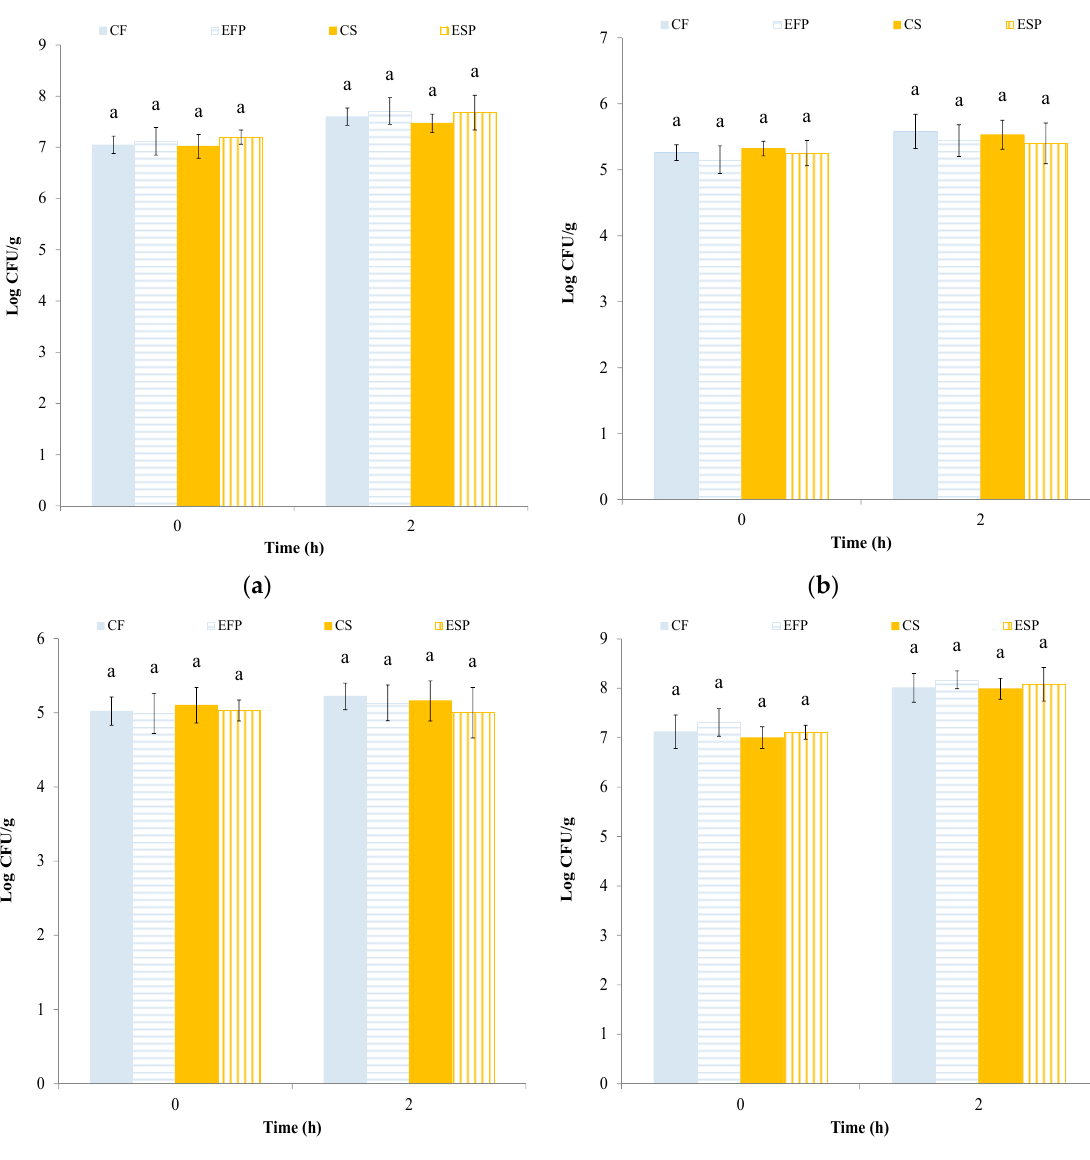
Figure 1. Microbiological counts during fermentation. ( a ) PCA, plate count agar for total mesophilic microorganisms (TMM); ( b ) mMRS, modified de Man, Rogosa, and Sharpe agar for generic food lactic acid bacteria (LAB); ( c ) SDB, sour dough bacteria agar for sourdough LAB; and ( d ) YPD, yeast extract peptone dextrose agar. for yeasts. Results indicate mean values and standard deviation of four determinations (carried out in duplicate for two independent productions). a Histograms followed by the same letter are not significantly different according to Tukey’s test. Abbreviations: